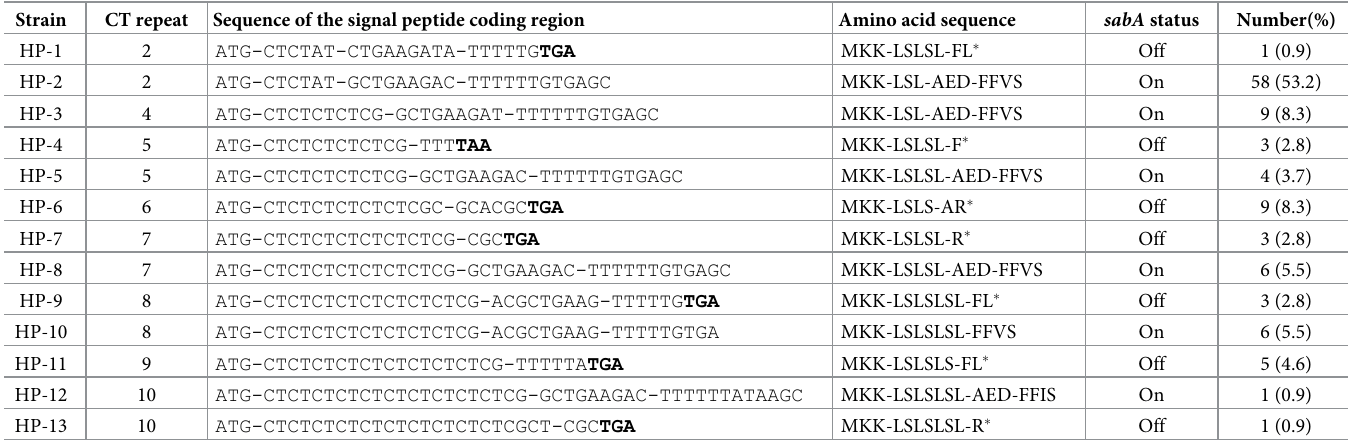
Table 3. Frequency of the sabA CT repeats patterns.